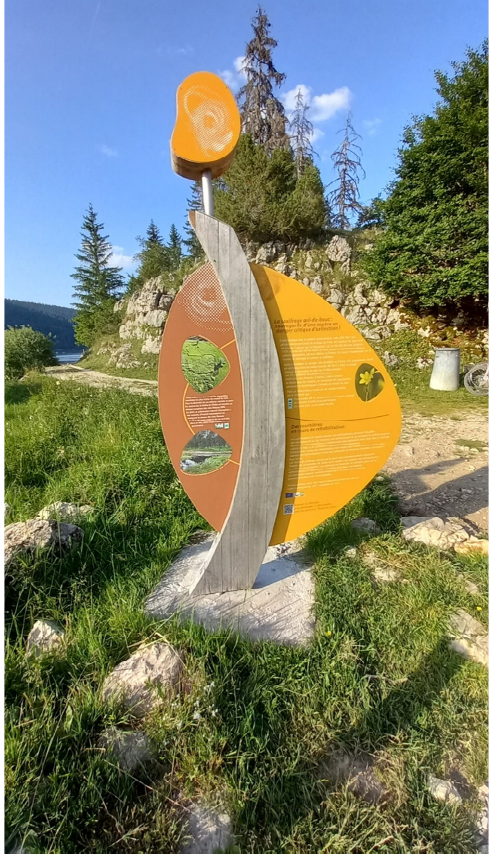
Figure 2. Board with an unusual visual design (Les Rousses, Jura, France) (Megerle 2022).